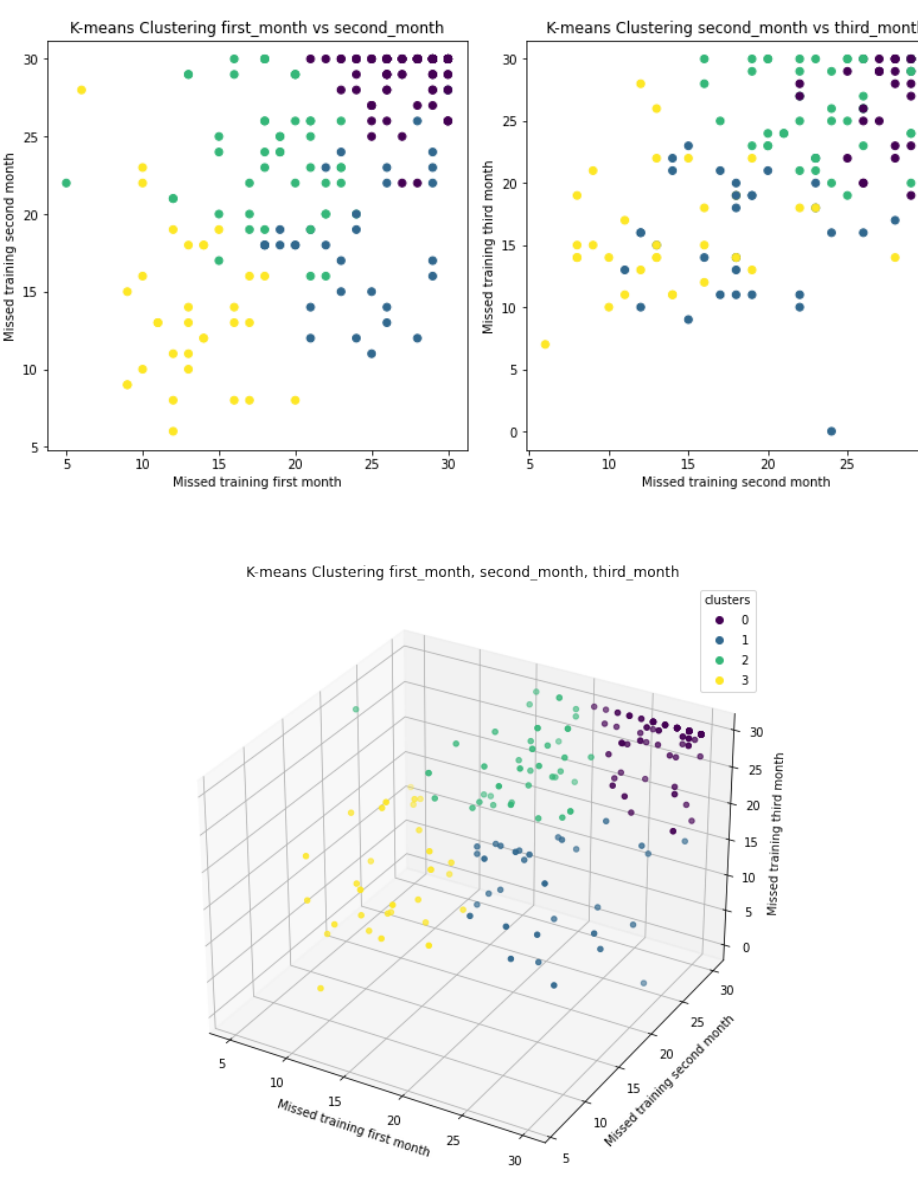
Figure 8. 4-means clustering taking “missed first month”, “missed second month” and “missed third month”as features